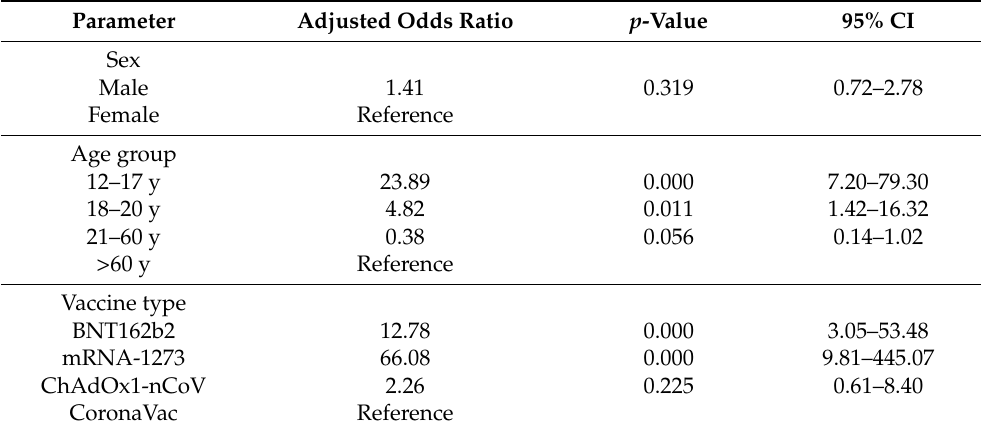
Table 5. Multivariate logistic regression analysis to estimate the odds of myocarditis/pericarditis following COVID-19